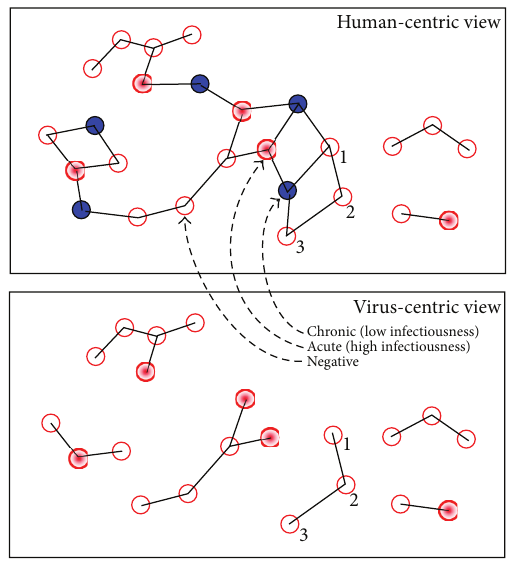
Figure 2: (Top) Risk network with 10 HIV+ (4 acute) out of 26 nodes; (bottom) virus-centric view, FW: 6/16 = 0.375 .